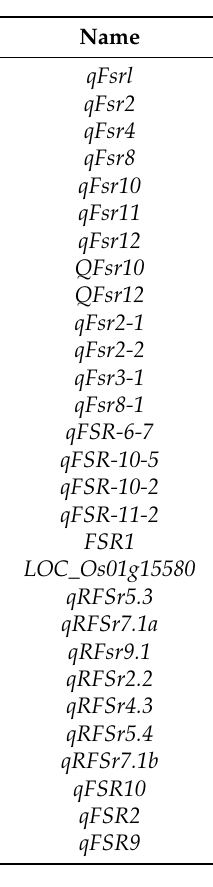
Table 2. QTLs associated with